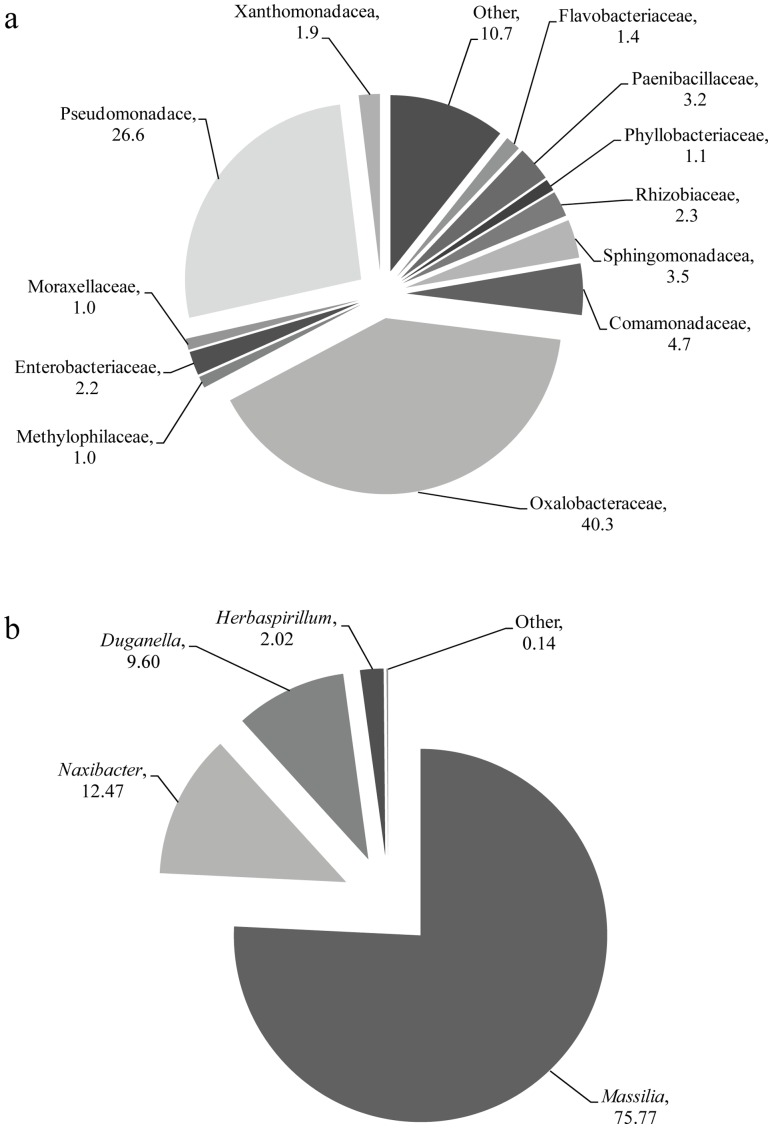
Composition of cucumber (Cucumis sativus) seed- and root-colonizing bacterial (a) and Oxalobacteraceae community (b), based on 454-pyrosequencing of general bacterial 16S rRNA gene fragments.Sequences were obtained from samples of seeds (1 day) and roots (2, 7 and 21 days old) grown in perlite and compost-amended perlite, with and without inoculation with Pythium aphanidermatum (1day only). Numbers indicate the relative abundance of the indicated taxon (% of total bacteria). Families for which relative abundance was ≥1% are included in panel a.